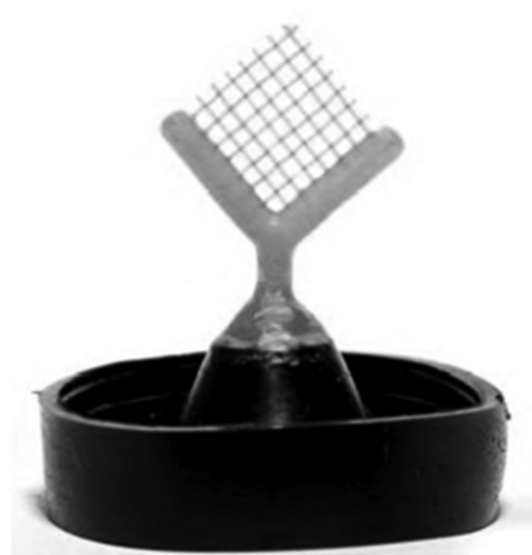
Figure 1. Wax pattern for castability